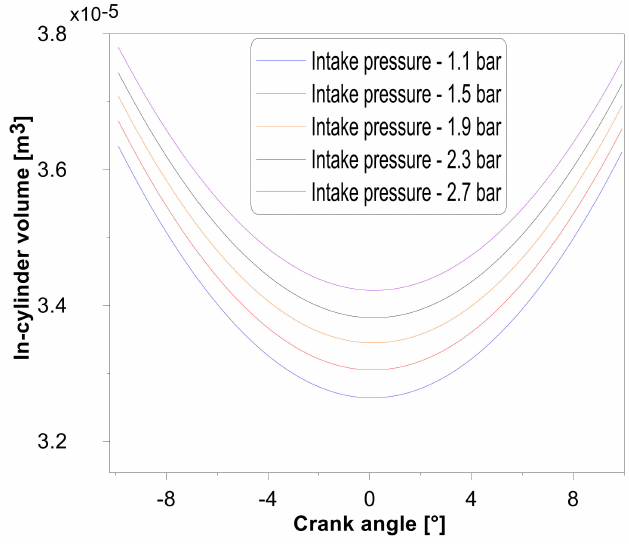
Figure 13. Instantaneous volume for each condition taking into account the measured